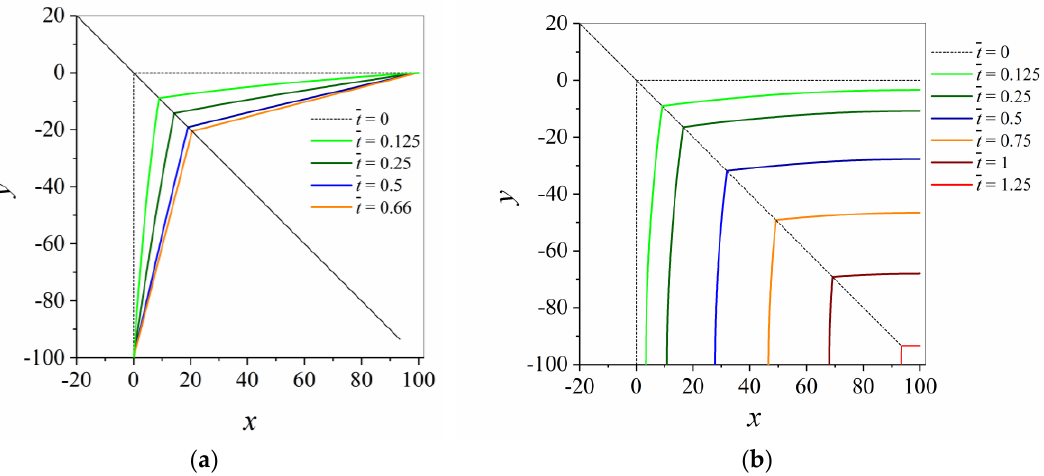
Figure 7. Evolution of the grain boundaries and the triple junction with Λ = 2 determined numerically: ( a ) Case I: Boundary conditions for infinite grains. ( b ) Case II: Boundary conditions for finite